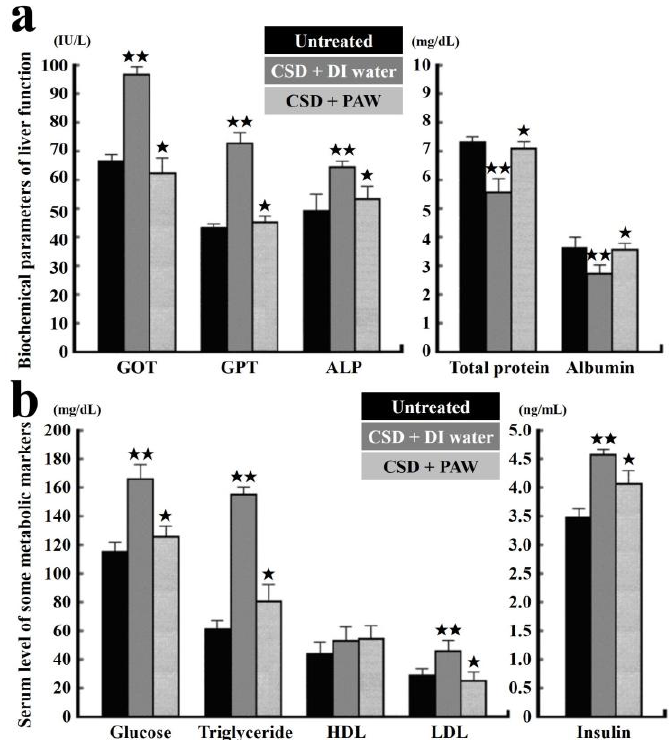
Figure 9. Histograms showing the serum level of biochemical markers related to liver ( a ) and metabolic ( b ) functions. Note that CSD contributes to severe liver and metabolic deficiencies. However, drinking of PAW successfully exerts beneficial effects on liver and metabolic function, in which almost all biochemical markers were noticeably returned to nearly normal values. ★ p < 0.05; ★★ p < 0.01 [76].